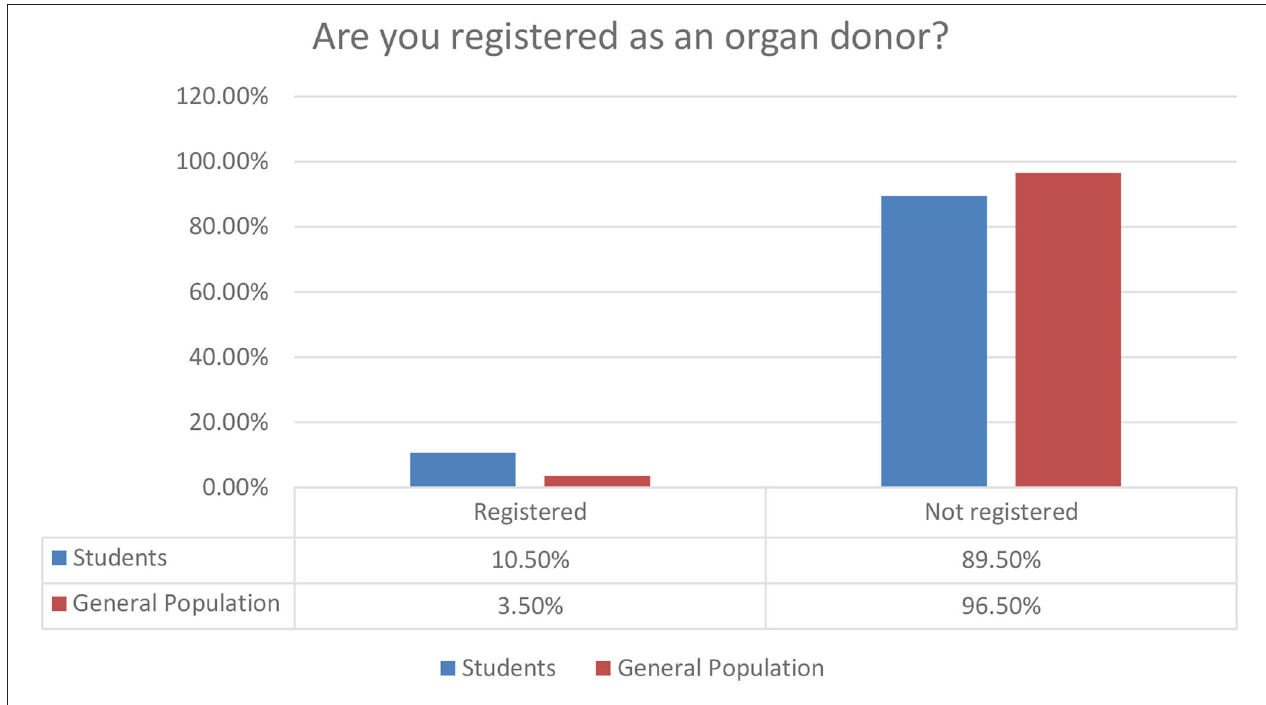
FIGURE 11 | Organ donor registry